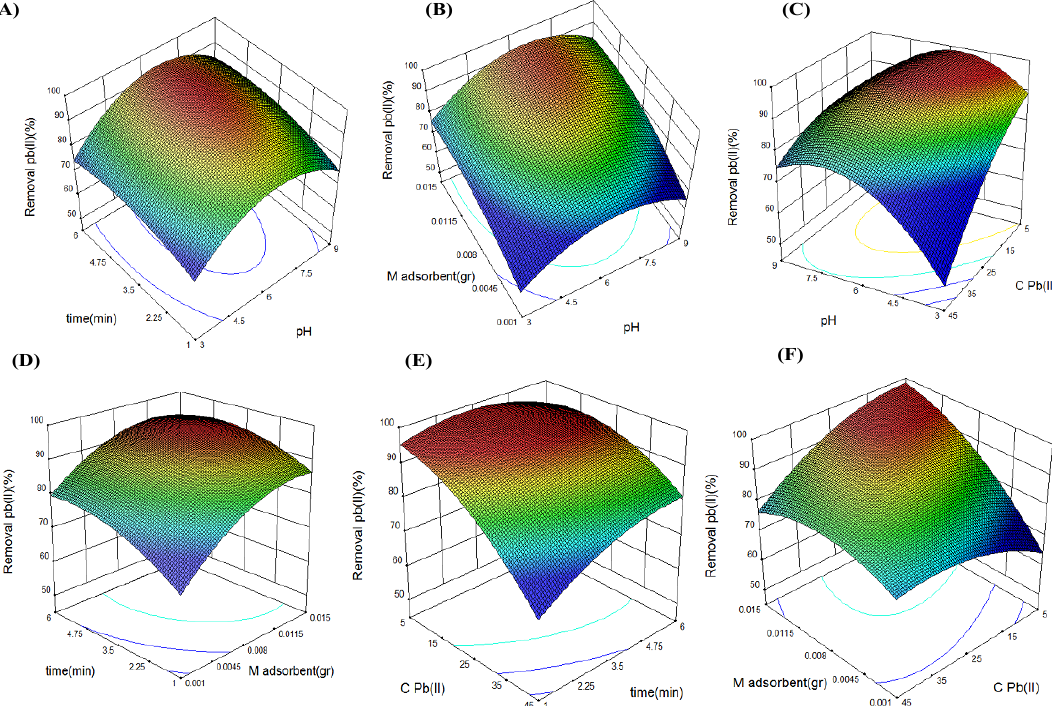
Fig. 3. The 3D surface plots for removal of Pb +2 ions. The response percent versus (A) the stirrer time and pH, (B) the amount of adsorbent and pH, (C) pH and the concentration of Pb +2 ions, (D) the stirrer time and the amount of adsorbent, (E) the concentration of Pb +2 ions and the stirrer time, (F) the amount of adsorbent and the concentration of Pb +2 ions.